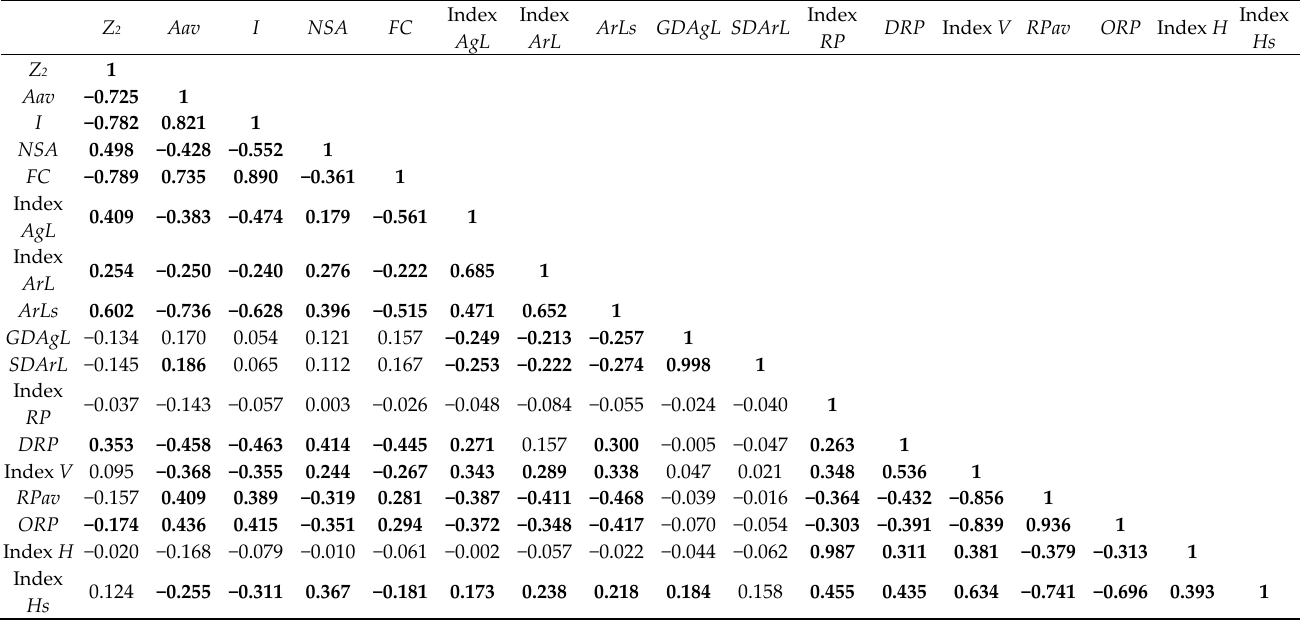
Figure 6. Eigenvalues and cumulative variance of principal components (low–low). Table 8. Correlation matrix of the principal component analysis [Pearson ( n )] for the low–low cluster. Values in bold are different from 0 with a significance level α = 0.05.